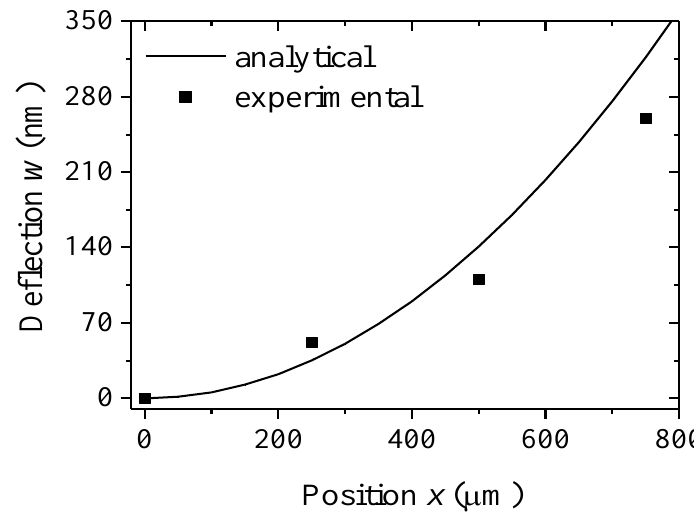
Figure 3. Steady deflection of a DNA-microcantilever sensor at each position of the cantilever.